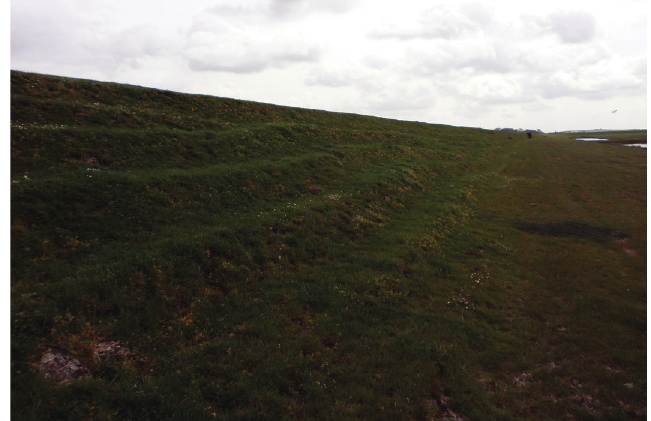
Fig. 2. Sheep grazed sea wall with a homogeneous, short sward; credit T.